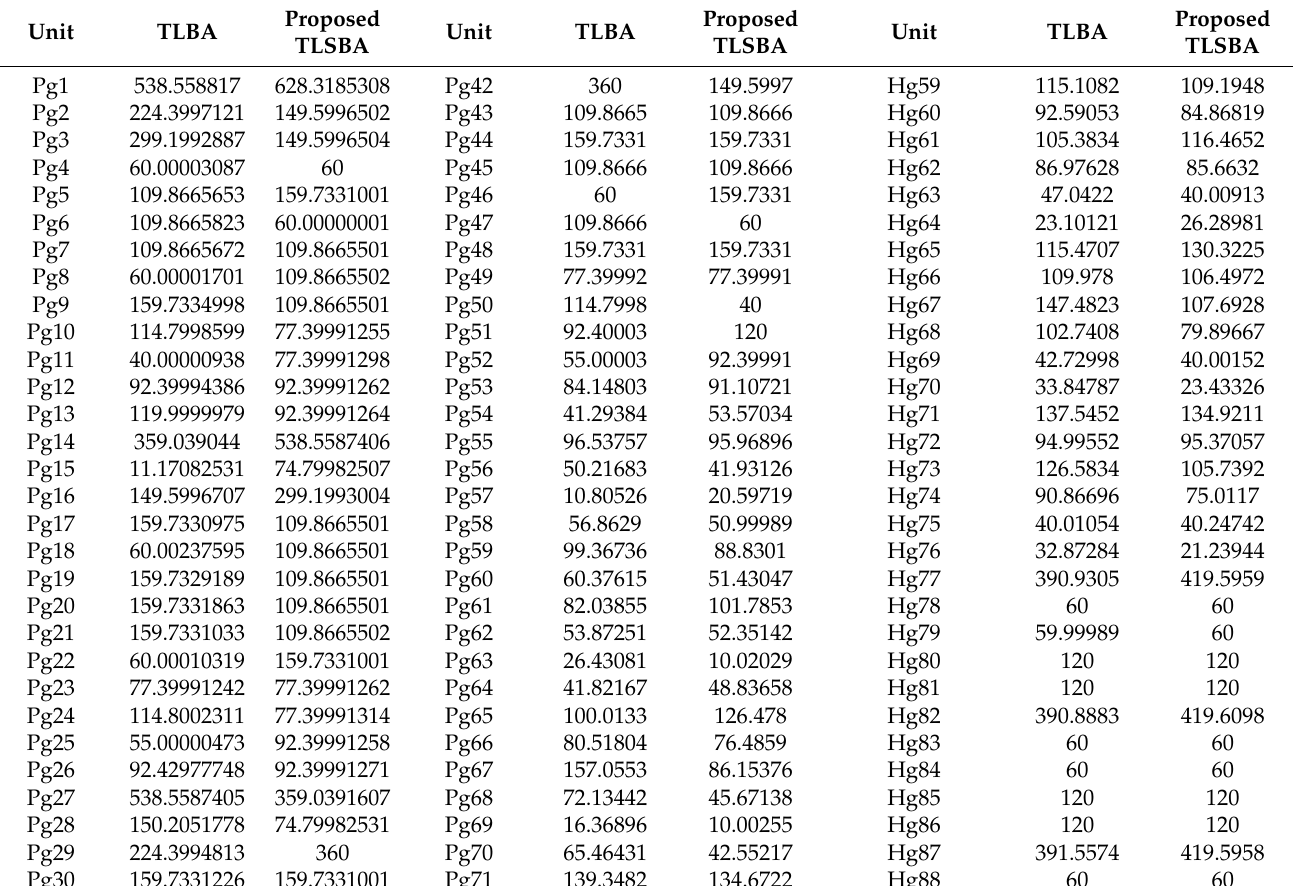
Table 6. Results of the 96-unit CHPED system from conventional TLBA and proposed